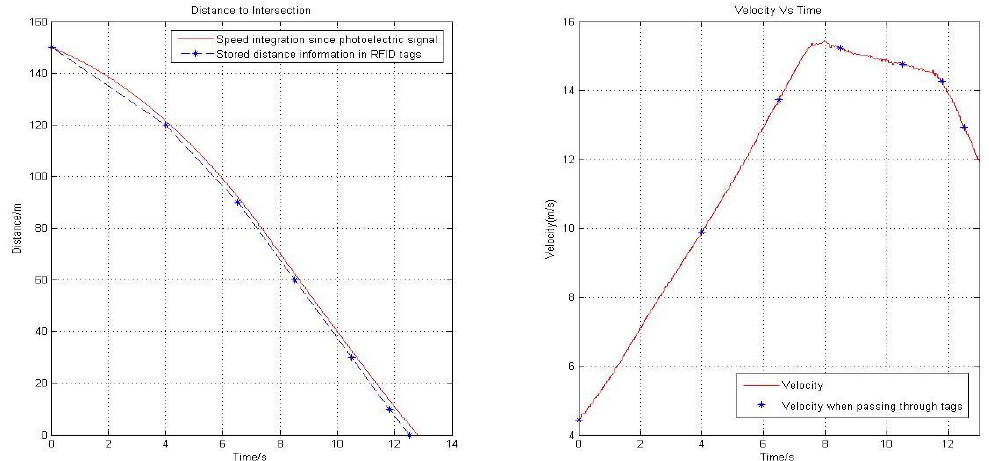
Figure 8. Results of experimental verification based on photoelectric